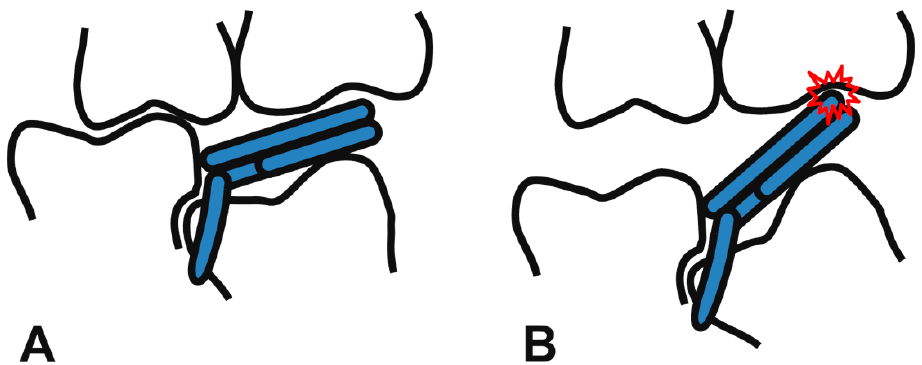
Figure 4. Favorable state of the mRS engaged on a slightly tilted molar ( A ), and unfavorable state of the mRS on a severely tilted molar ( B ). A severe mesial angulation of the locked molar leads to occlusal interference (red collision mark, ( B )). RS and mRS are not recommended in such